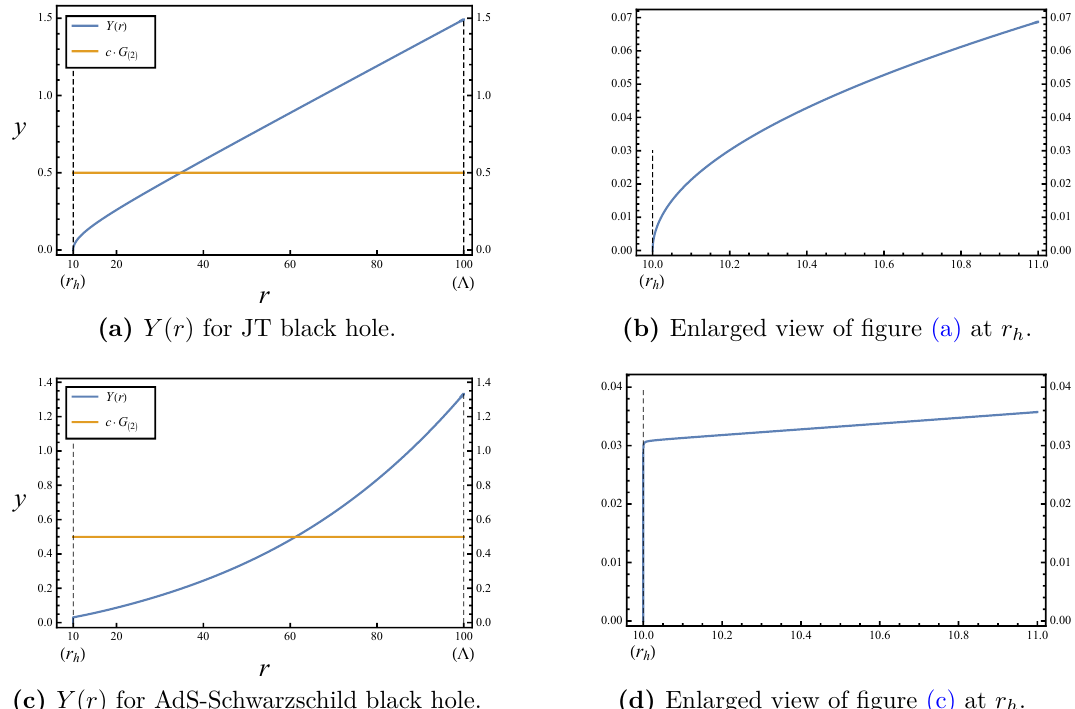
Figure 5. The ratio of the late-time radiation entropy given by the two roots of (2.15) for (asymptotically) flat black holes. a represents the root near r The numerical result shows that the root near the horizon will always be the boundary of island, if there is one.